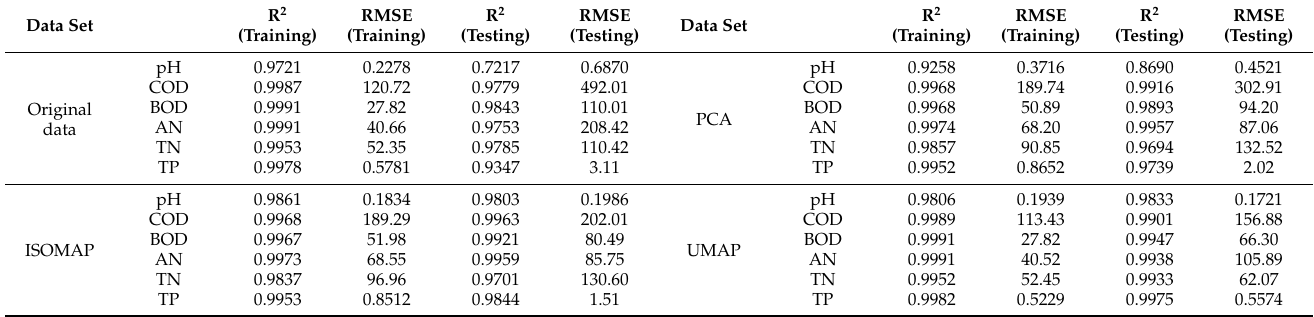
Table 6 summarizes the prediction results based on different data reductions for five chemical parameters. All in all, prediction results based on XGBT have achieved better results compared to lightGBM models. Different from PCA-lightGBM models, PCA-XGBT models have a slight edge over the (original data)-XGBT models in the testing set. The prediction of five chemical parameters based on the UMAP-XGBT model showed the best performance with an R 2 higher than 0.99 in the training set and testing set. Table 6. Comparison of the XGBT prediction models based on different manifold learning